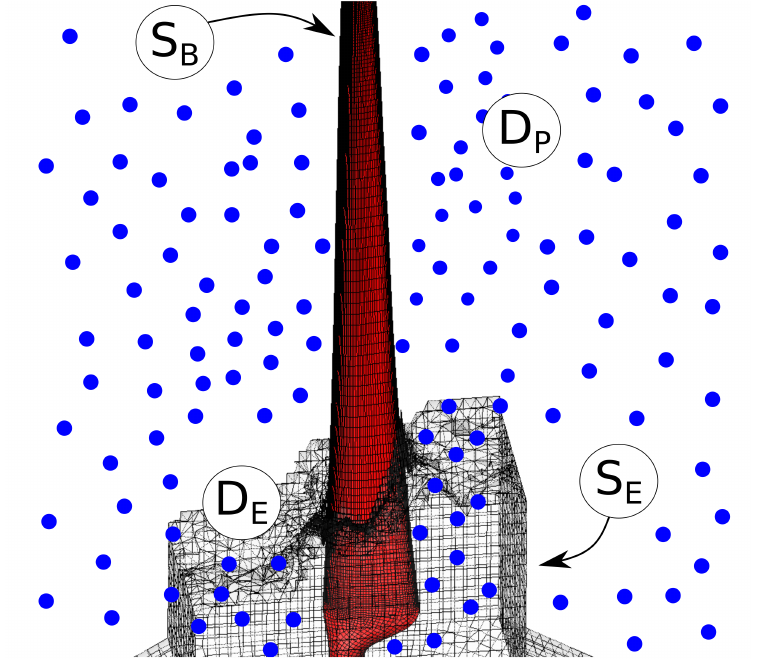
Figure 1. Decomposition of Eulerian ( D E ) and Lagrangian ( D P ) computational domains. S B denotes the solid-wall boundaries, and S E the far-field of the Eulerian domain.